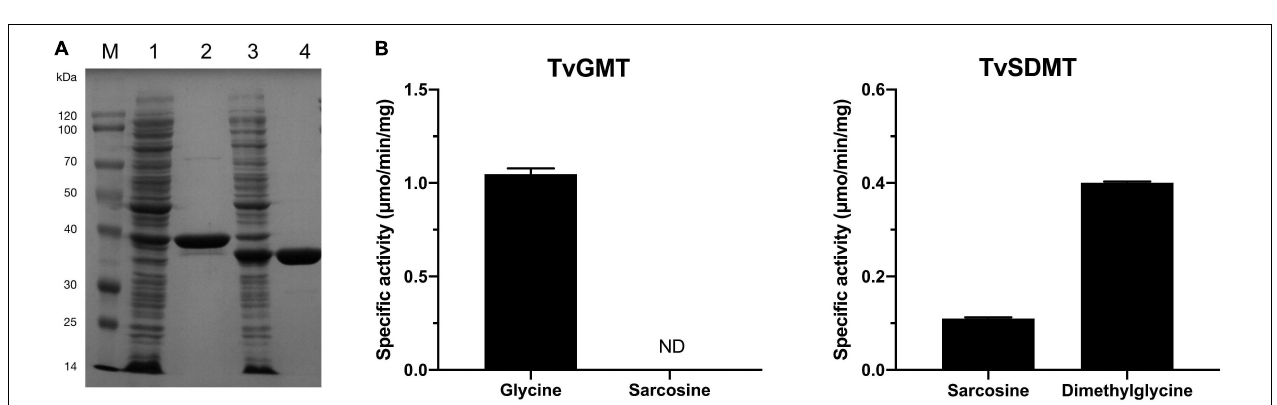
FIGURE 4 | Qualitative and quantitative analysis of glycine betaine in T. versutus D301 grown under high-salt (3.0 M) and low-salt (0.4 M) conditions, respectively. (A) The red and black traces are the LC-MS data for monitoring protonated glycine betaine (m/z = 118) under high-salt and low-salt conditions, respectively. (B) Quantitative analysis of glycine betaine production by HPLC. Data are the average of three biological replicates and the error bars represent the s.d.